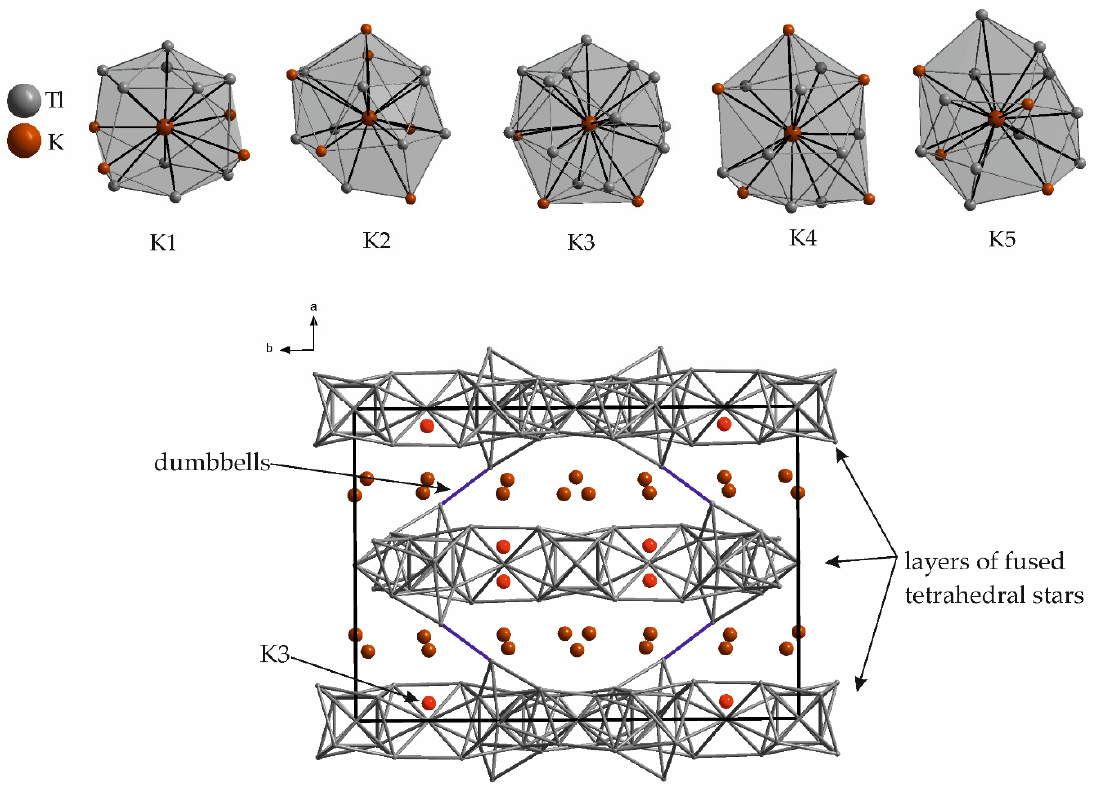
Figure 2. Surroundings of the five crystallographically independent potassium atoms in K 6 Tl 17 . The range of distances as well as the Wyckoff letters for each atom are given in Table 1. In the unit cell, the K3 atoms are located within the layers of fused tetrahedral stars (dark red), while the remaining potassium atoms are situated between these layers (bright red).